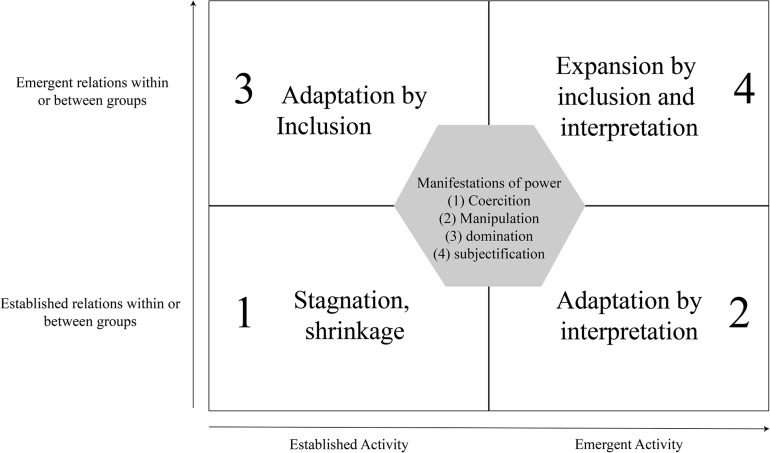
A framework to analyze power in expansive learning processes from Schirmer and Geithner (2018) and Blacker and McDonald (2000).